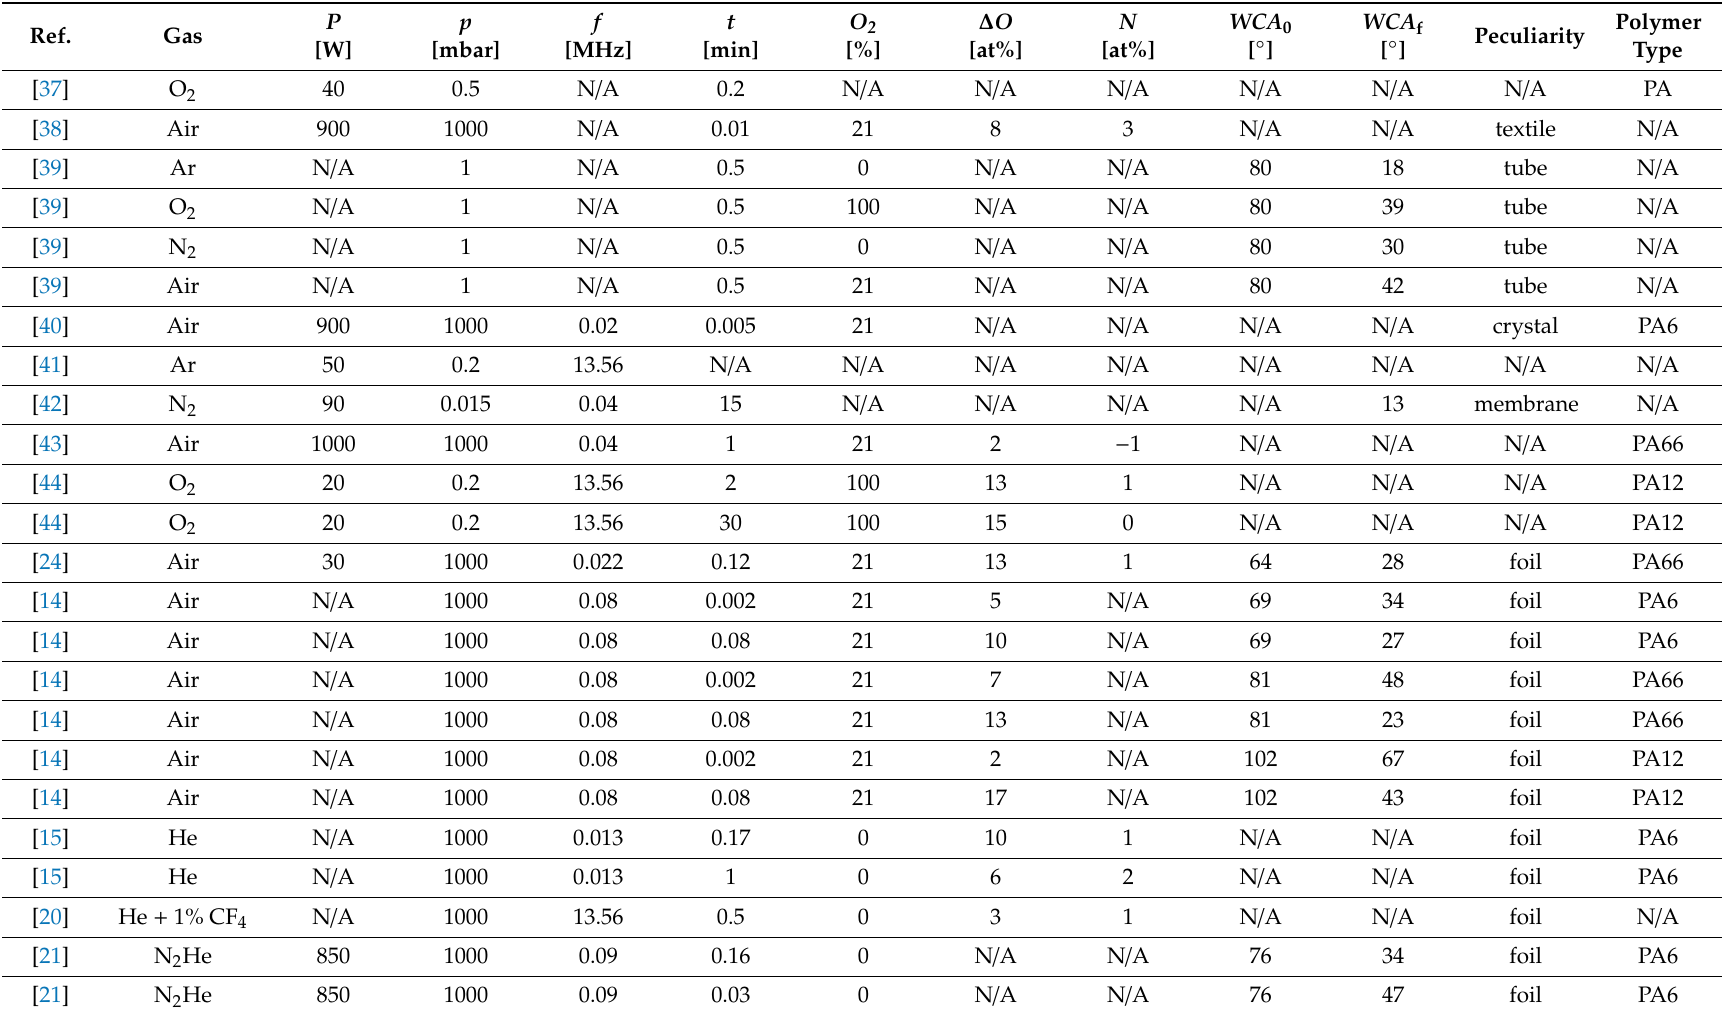
Table 1. Summary of the reported